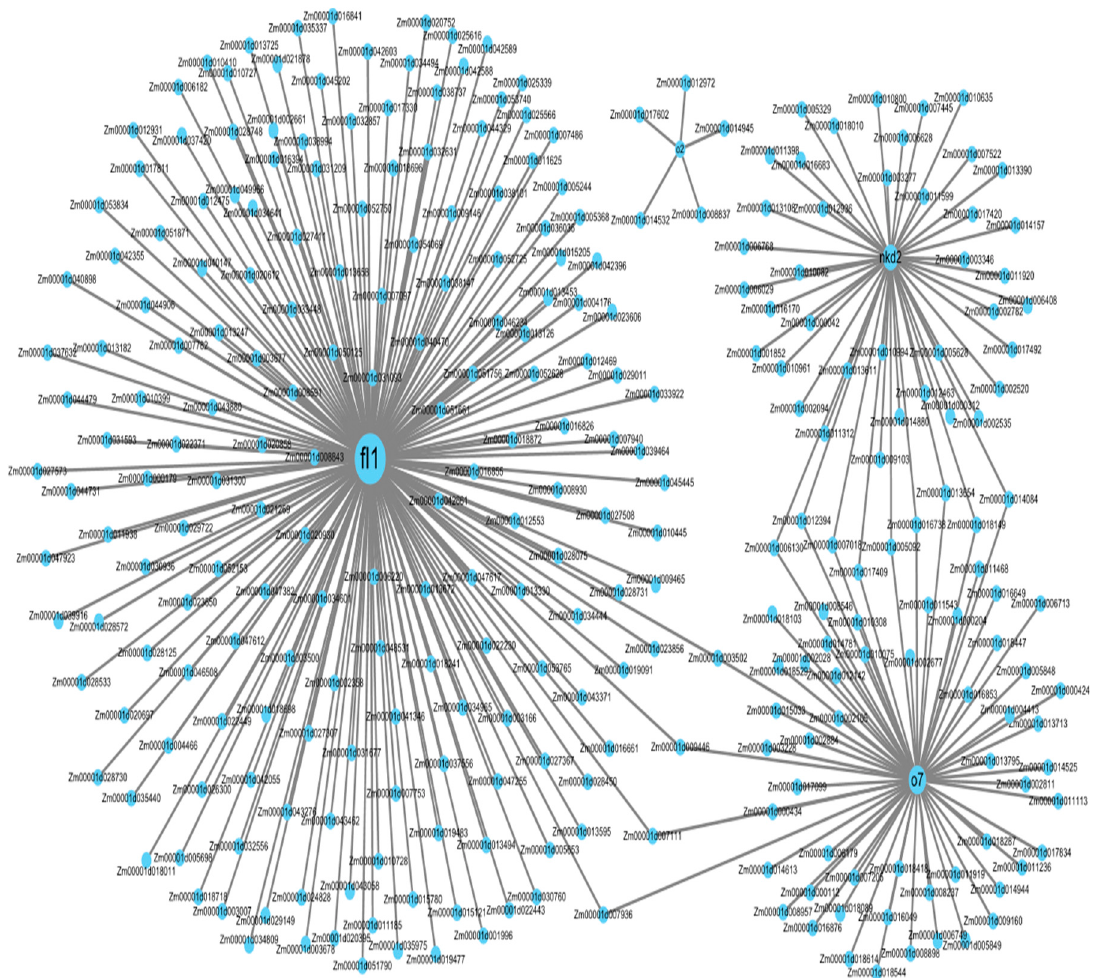
Figure 7. Visualization of the network connections among fl1 , o7 , nkd2 and o2.